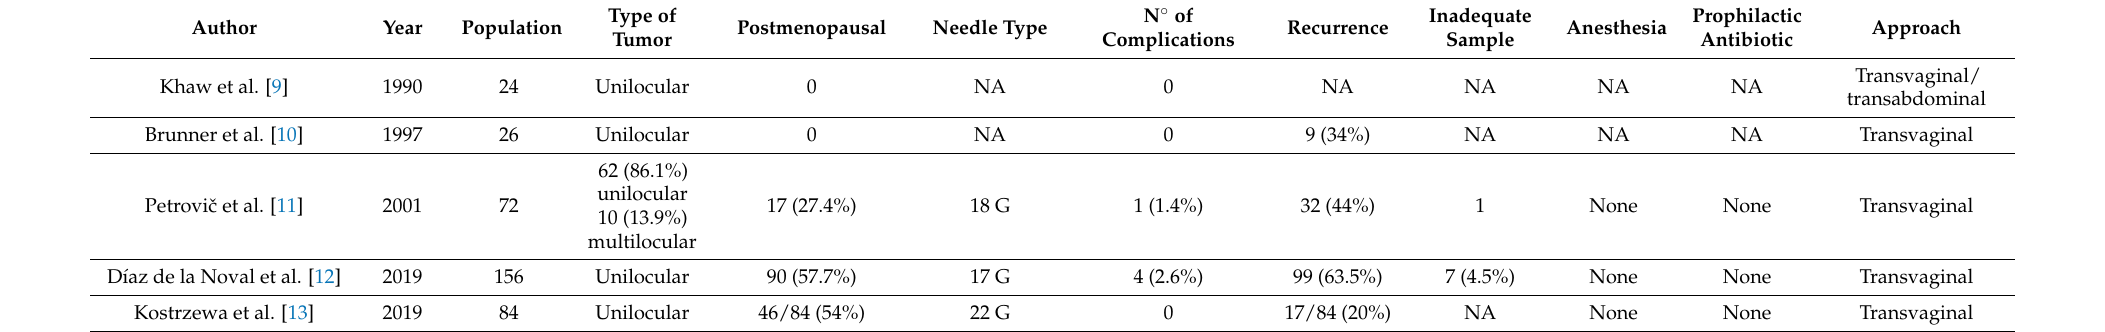
Table 1. Characteristics of patients undergoing cytological